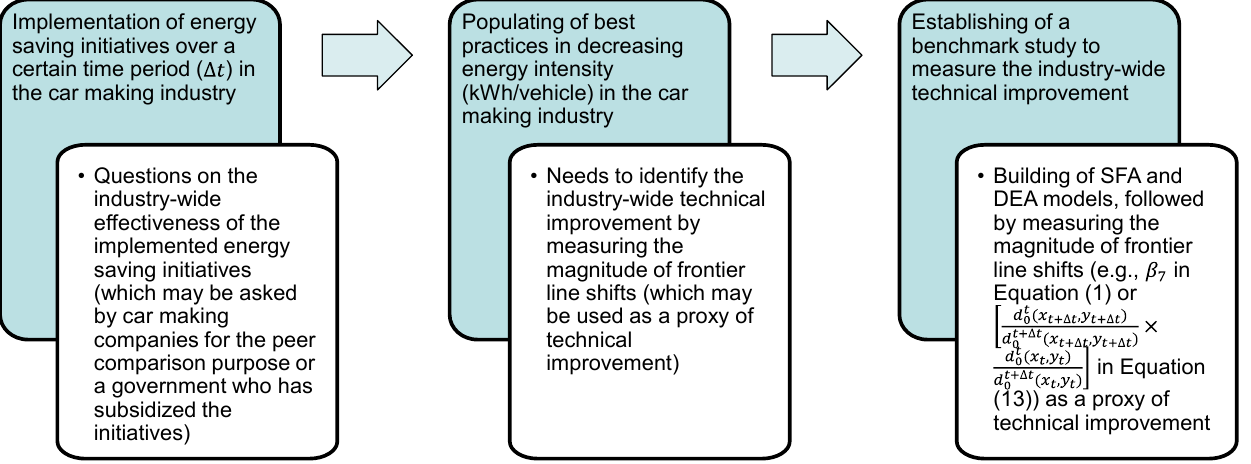
Figure 3. The idea process for measuring the effectiveness of energy saving